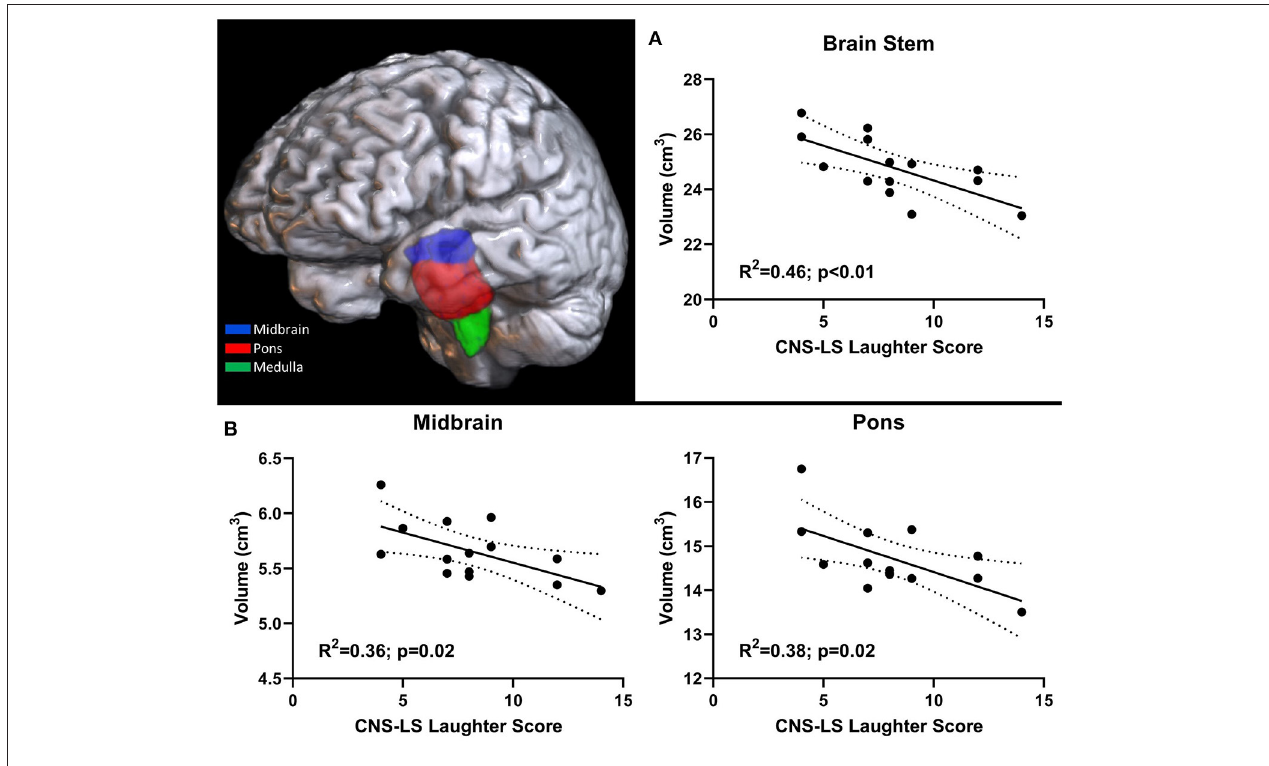
FIGURE 1 | 3D rendering of brainstem segmentation in an individual participant. Significant correlation between pathological laughter severity and (A) total brainstem volume, (B) midbrain and pons volume in ALS